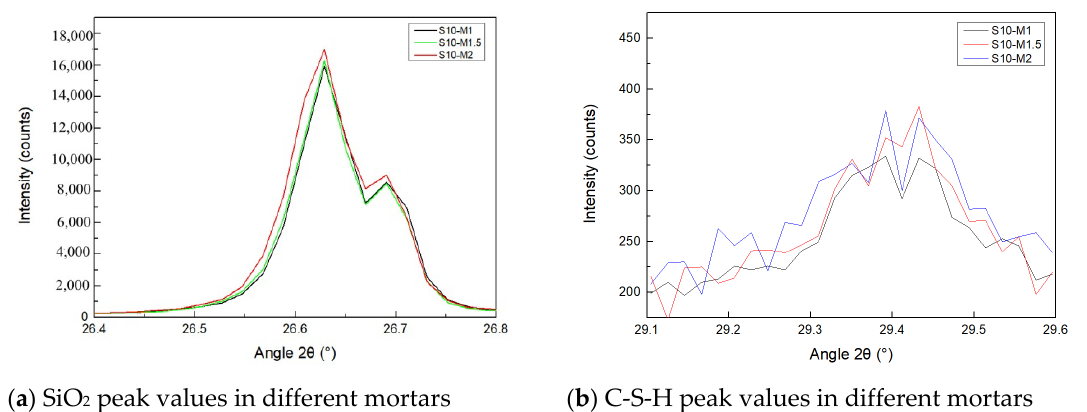
Figure 19. Effect of different modulus on comparison of peak values of SiO 2 and C-S-H of samples.